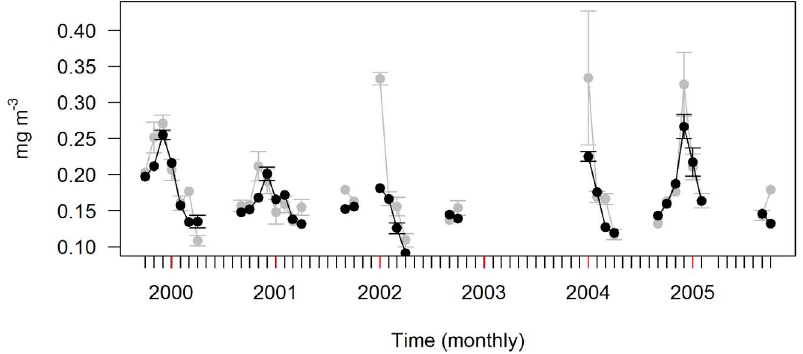
Figure 7. Mean inter-annual cycles. The chl-a (grey) and light-based chl-a estimates from our final mixed model collected by TDLRs (TDLR chl ) – black) mean inter-annual cycles within a 55 u S to 60 u S latitudinal band of the study site ( i.e. where seal density is highest – see Table 3). Values include standard error bars. Red ticks on the x-axis represent January of each year. N.B. mean inter-annual trends are incomplete because study lacked PB deployments for 2001, 2002 and 2003, and PM deployments for 2003 (see Table 1). Furthermore, mixed model analysis excluded winter months (see Results).